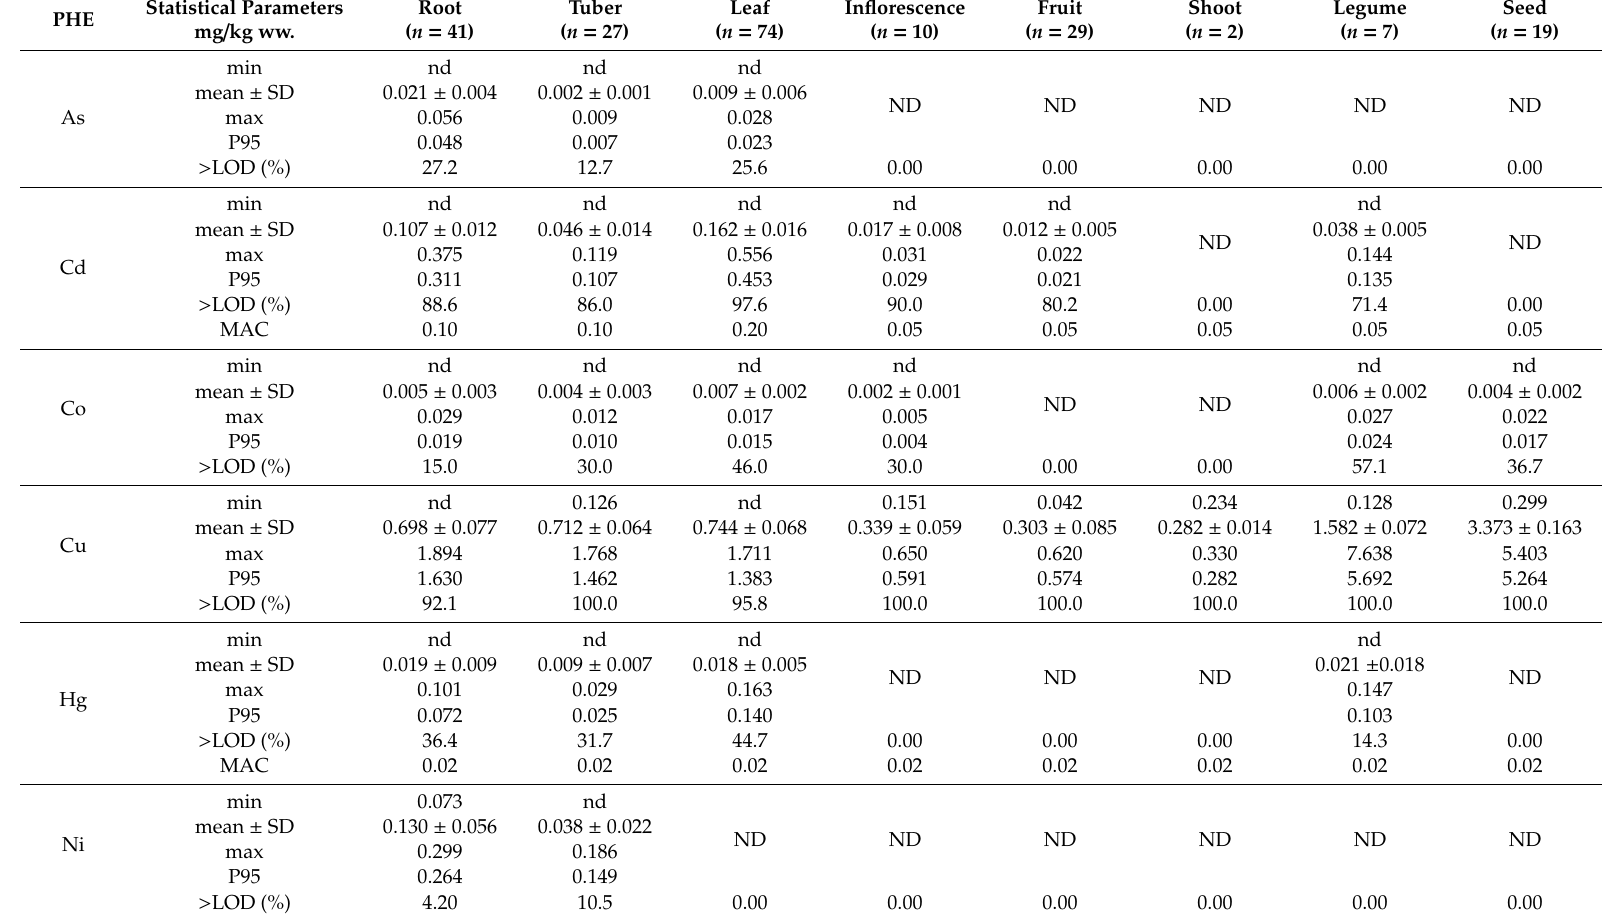
Table 3. Concentrations of potentially harmful elements (PHEs) (mg / kg ww.) in the groups of vegetables. Statistical Parameters PHE mg / kg